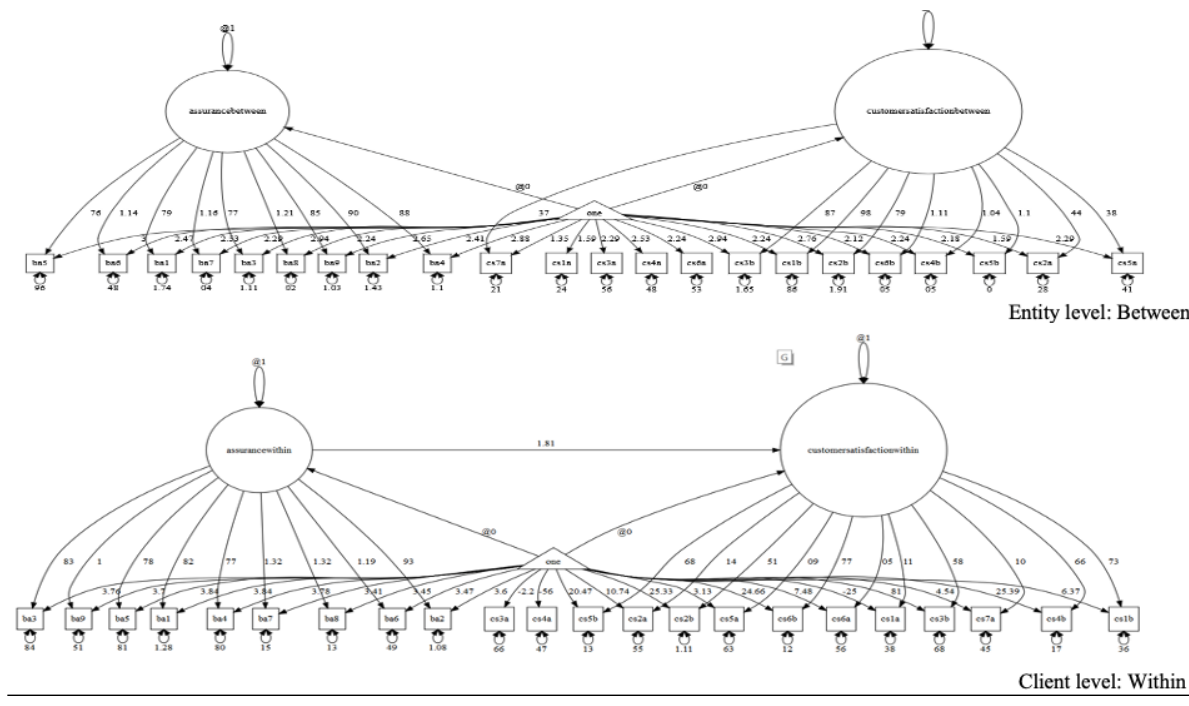
Figure 10: Path diagram showing the influence of Assurance on Customer Satisfaction